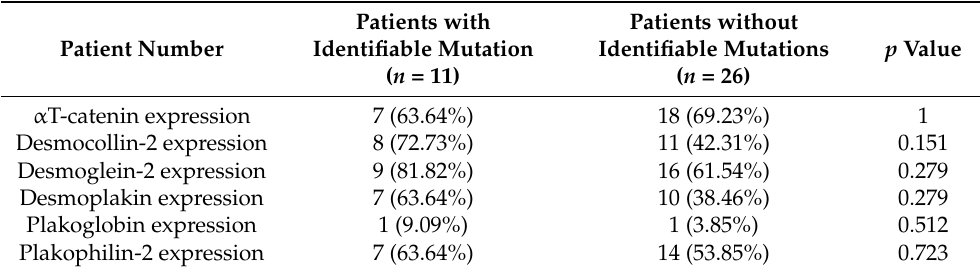
Table 3. Numbers of patients with reduced ICD protein expression between the ARVC group and the control